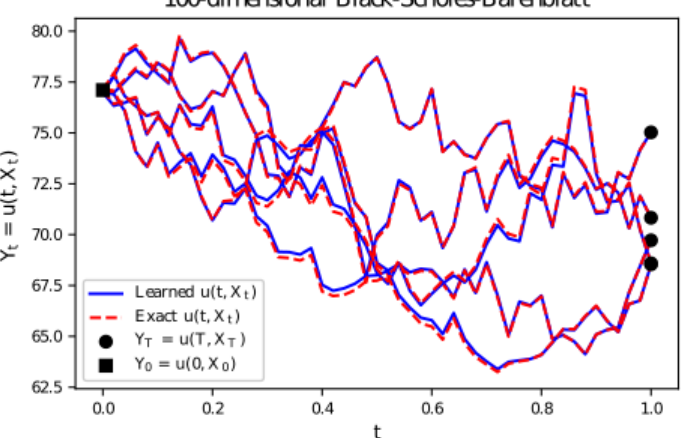
Figure 2. Evaluations of the learned solution Yt = u ( t , X t ) at representative realizations of the underlying high-dimensional process X t .